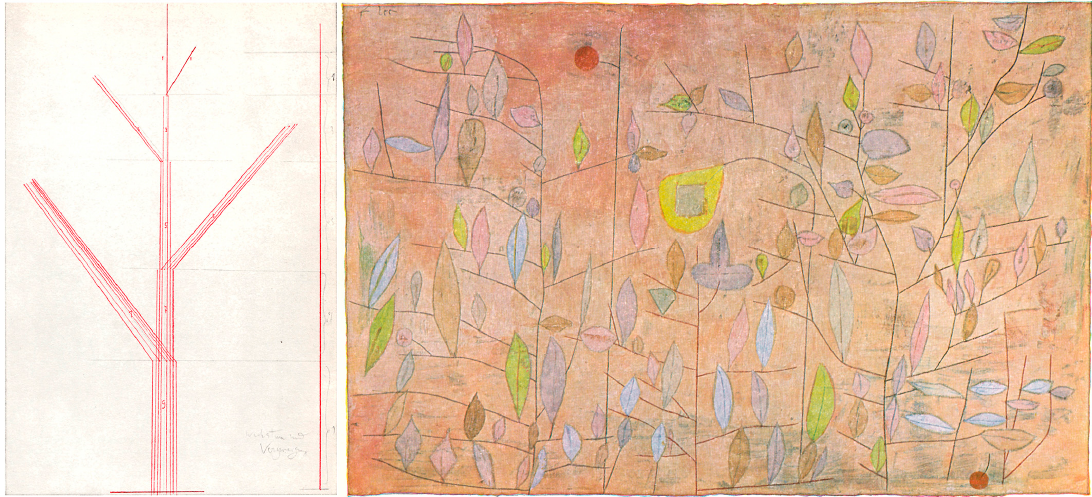
Figure 1. Paul Klee, Growth and ramification (pencil and red pencil) and Rare foliage (mixed technique and watercolor) [3] (pp. 2,